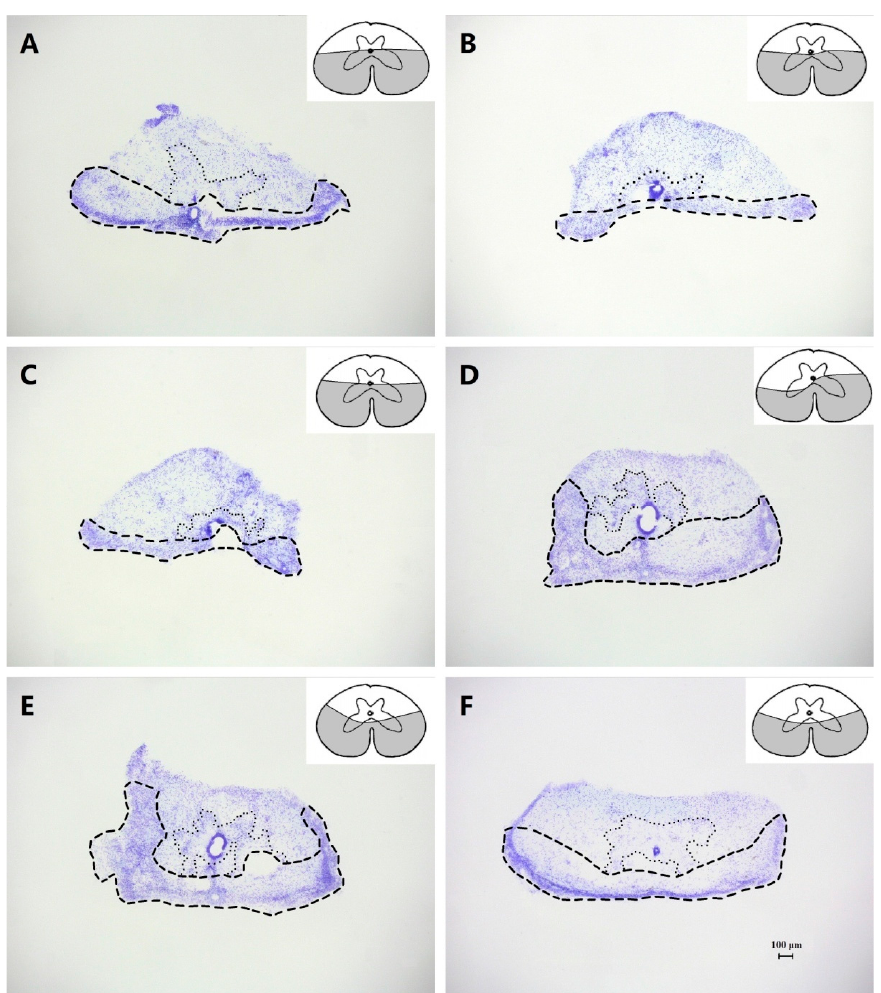
Figure 4. Photomicrographs and the corresponding schematic drawings of transverse sections, showing the extent of the spinal cord damage with ventral lesions in individual geckos. Scale bar = 100 µ m for all. In the photomicrographs, the lesioned area is delimited by broken lines, and the intact gray matter by dotted lines, with the remainder corresponding to the intact white matter. In the schematic drawings, the damaged area is